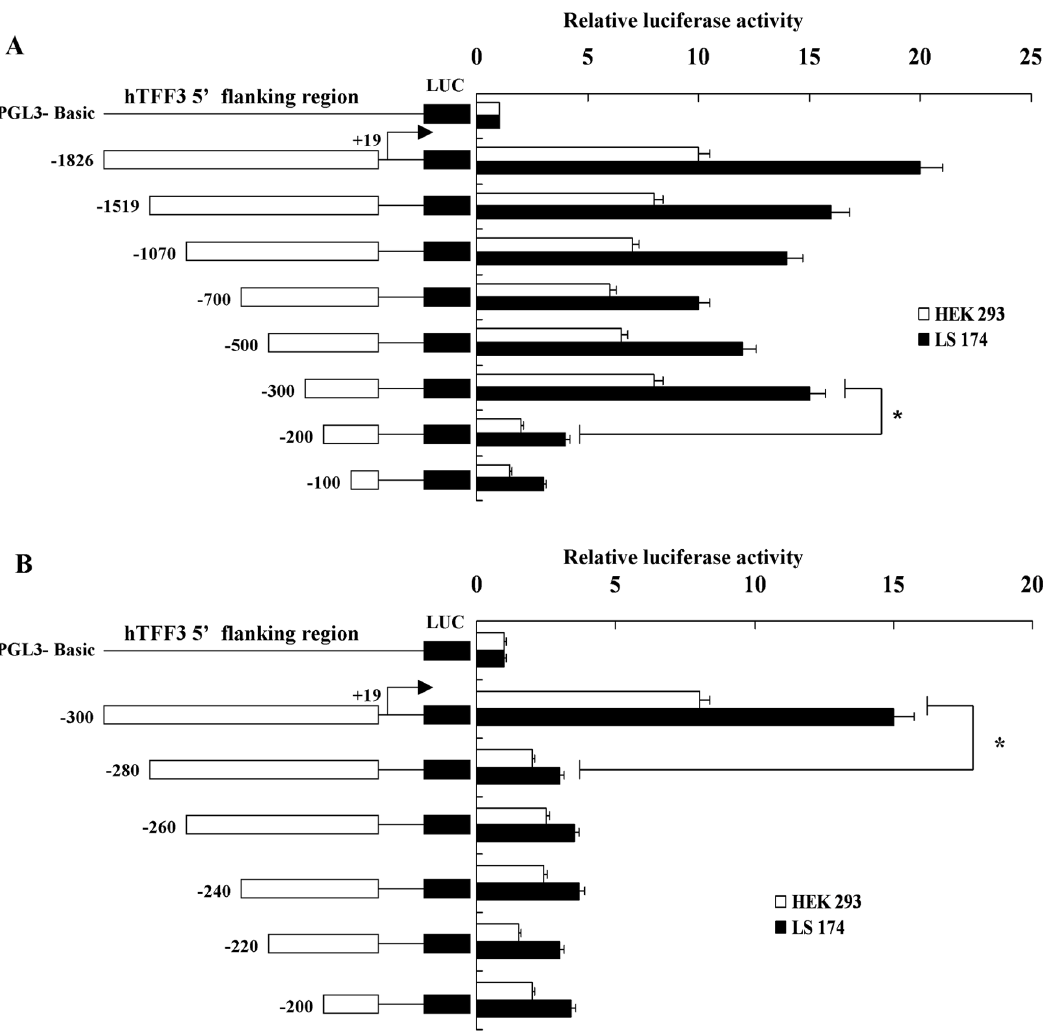
Figure 2. Analysis of hTFF3 promoter activity. hTFF3 promoters with different lengths were transfected into HEK 293 and LS-174T cells. The relative luciferase activity was calculated as the ratio of firefly luciferase to Renilla luciferase. At least three independent experiments were performed under similar experimental conditions. (A) the hTFF3 promoter ( 2 1,826 bp to 2 100 bp); B the hTFF3 promoter ( 2 300 bp to 2 200 bp). Data are presented as the mean 6 SD (*P , 0.05 vs .